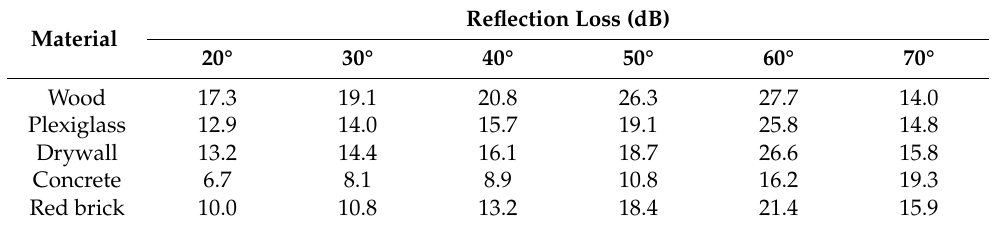
Table 6. The Average Reflection Loss [ P ref ( dBm ) − P L o S ( dBm ) ] at Six Incident Angles in D-band.